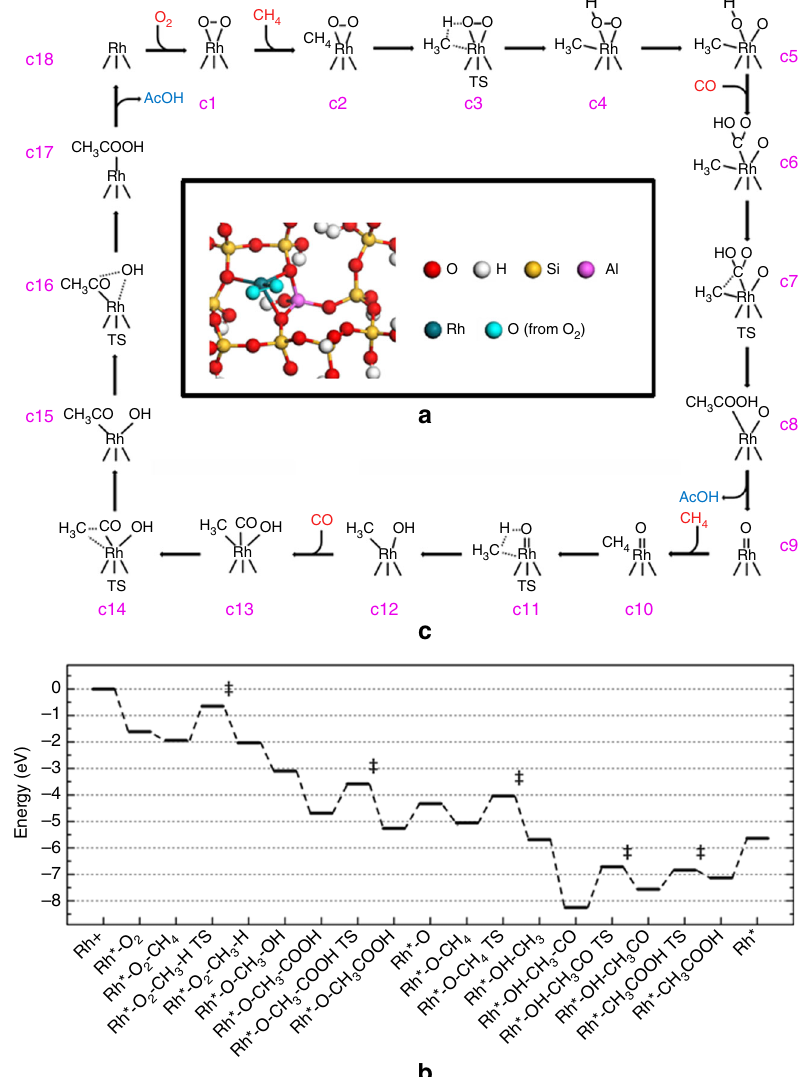
Fig. 6 Computational studies of reaction pathway. Minimum-energy paths and reaction schematic for formation of acetic acid from CH 4 , CO, and O 2 on Rh 1 O 5 /ZSM-5. The formation of acetic acid is illustrated in a catalytic cycle starting with the singly dispersed Rh 1 O 5 site. The balanced reaction cycle consumes one O 2 , two CH 4 , and two CO to make two CH 3 COOH molecules (2CH 4 + 2CO + O 2 = 2CH 3 COOH). a The optimized catalytic sites, Rh 1 O 5 anchored on Brønsted site in microspore of ZSM-5. b Energy pro fi le for pathway of transforming CH 4 , CO, and O 2 to CH 3 COOH. c Intermediates and transition states for a complete catalytic cycle, starting with Rh 1 O 5 (c1). Transition states are highlighted with the double dagger